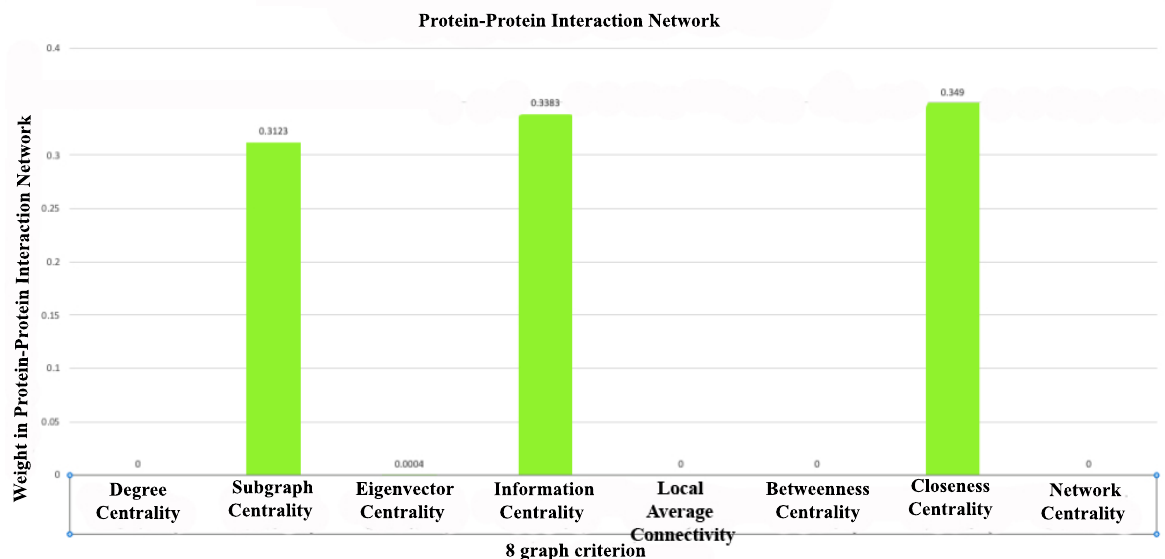
Figure 8. The average weighting of each criterion in the calculation of the important-score criterion by performing a 10-fold cross-validation on the DINGA system in the protein-protein interaction networks